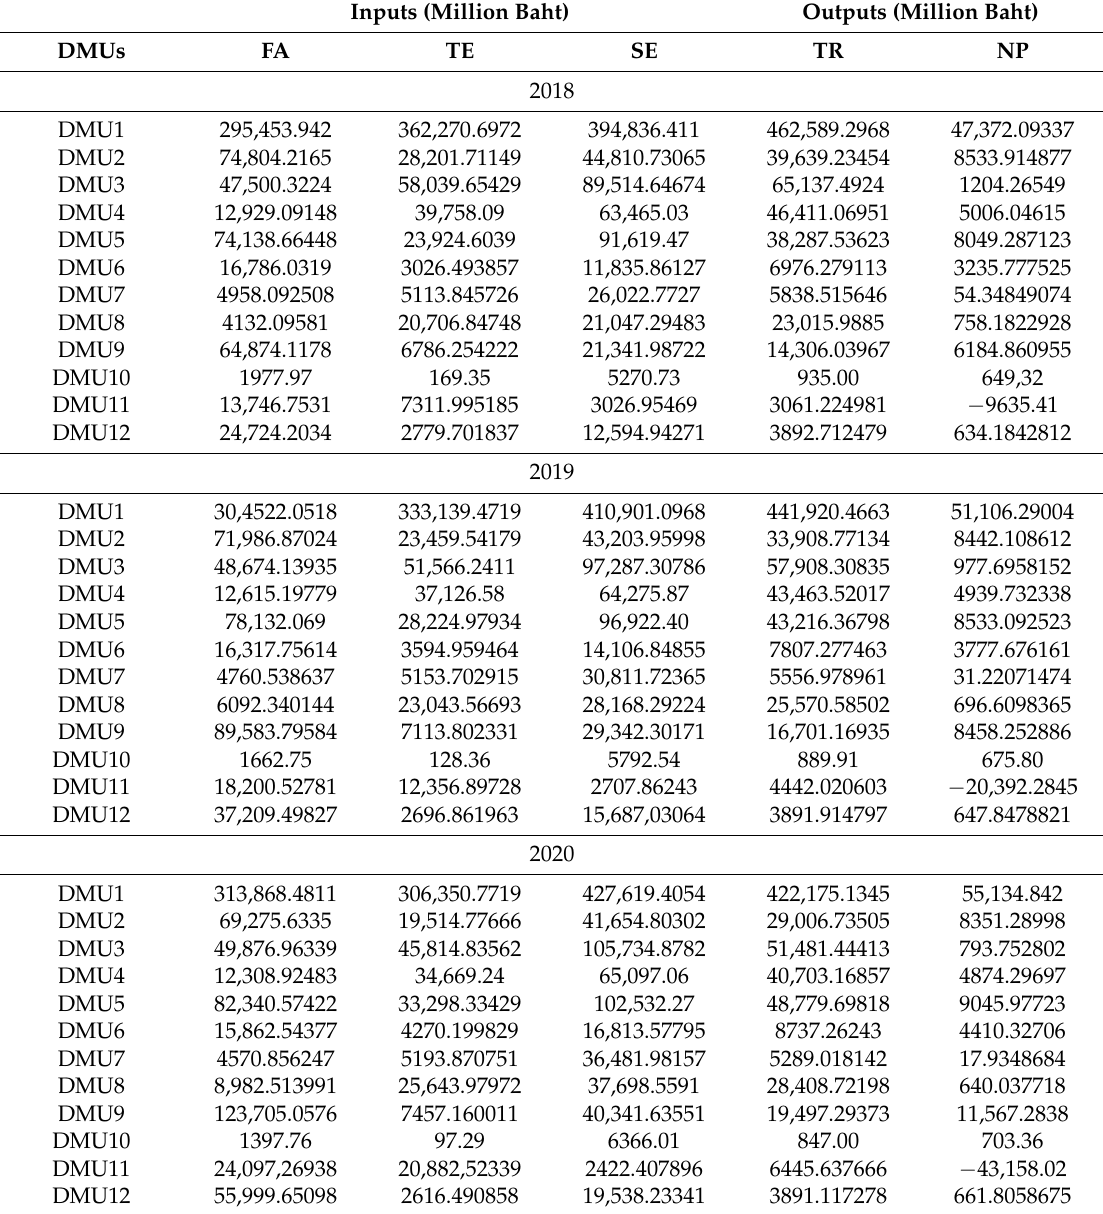
Table 11. The forecasted data of all DMUs from